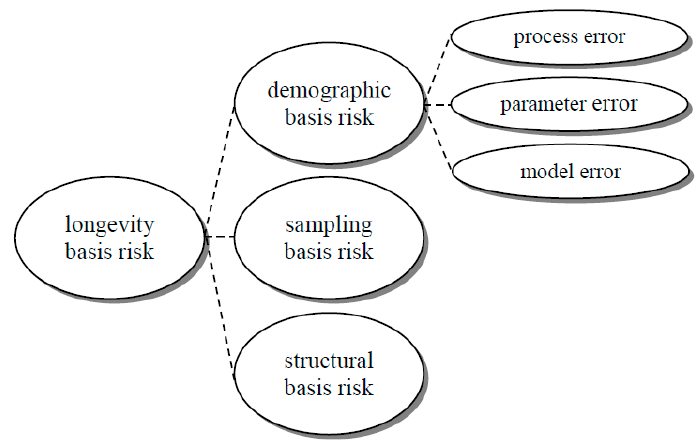
Figure 1. A modeling framework for longevity basis risk.